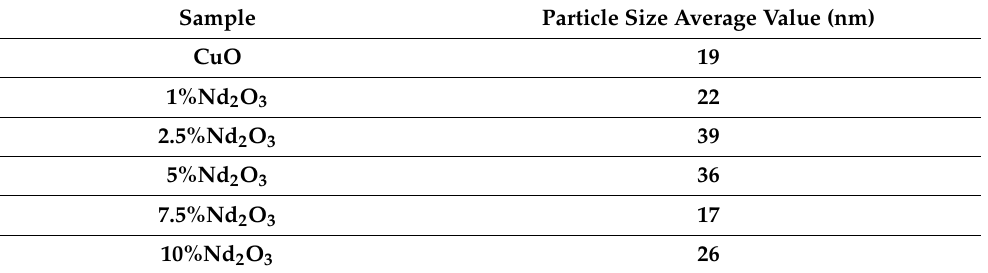
Table 3. The average particle size of all prepared samples.